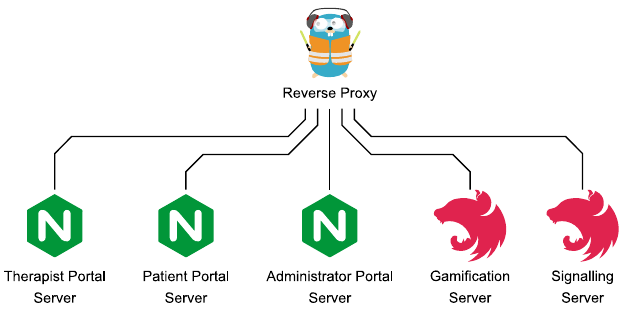
Figure 22. Reverse Proxy with proxied